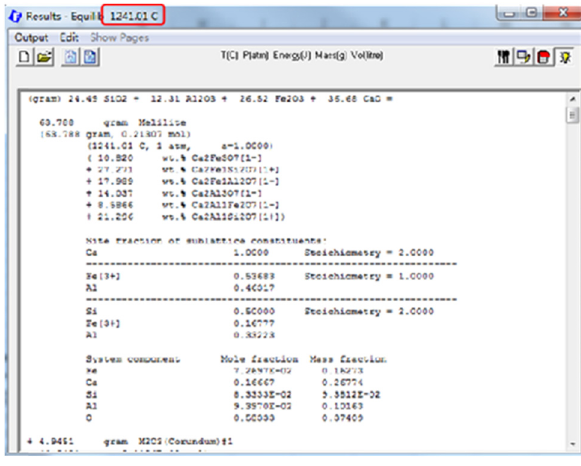
Figure A2: Database selection for calculating melting